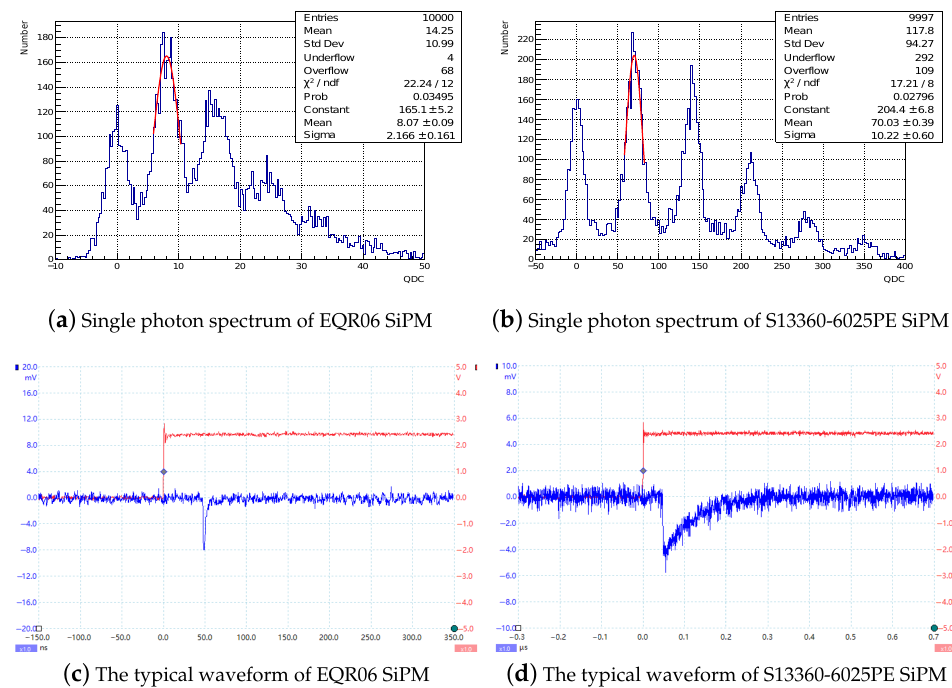
Figure 8. Single photon spectrum and typical waveforms in the oscilloscope of DUTs. Red pulses in ( c , d ) correspond to trigger